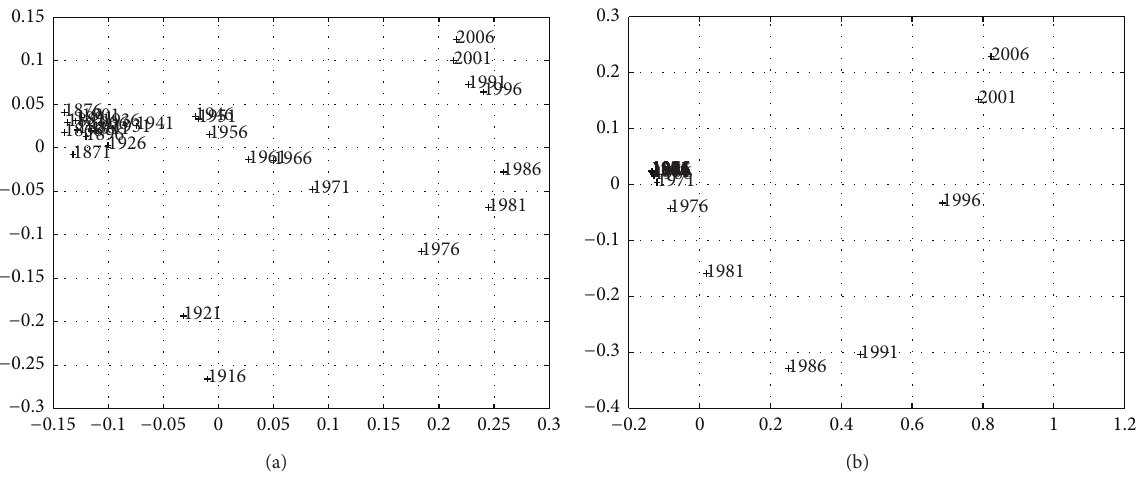
Figure 11: Two-dimensional MDS maps of the Portuguese economic evolution: 𝑇 = 1867 – 2010 , ℎ = 5 years for 𝑟 𝐶 (a) and 𝑟 𝐸